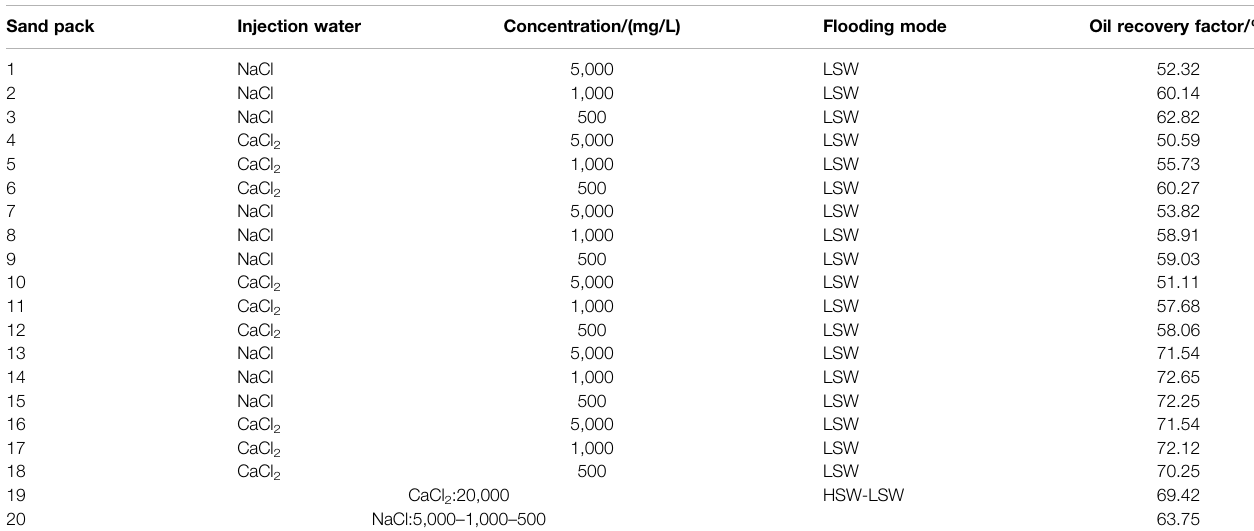
TABLE 5 | Experimental results of sand pack fl ooding. Sand pack Injection water Concentration/(mg/L) Flooding